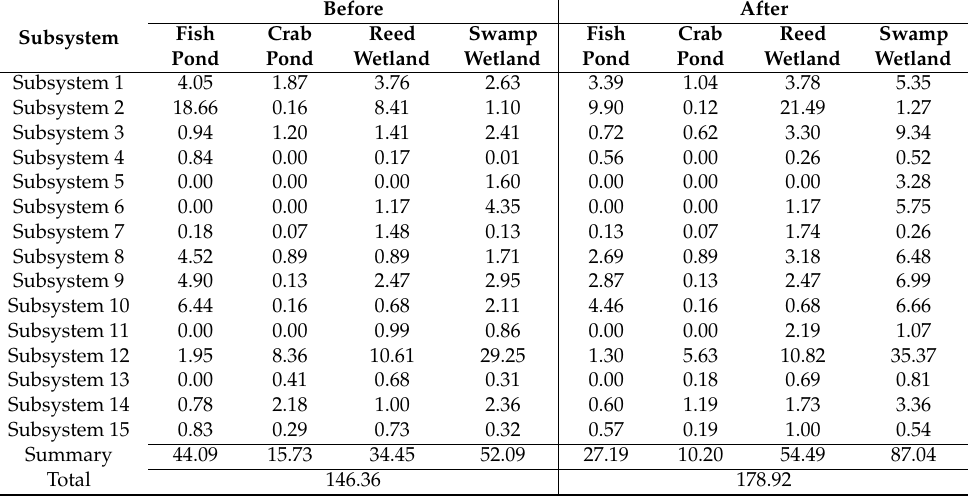
Table 2. Optimization scheme for the ecosystem services’ incremental values for the IRSNP (10 9 ¥). Before After Fish Crab Reed Swamp Fish Crab Reed Subsystem Pond Pond Wetland Wetland Pond Pond Wetland